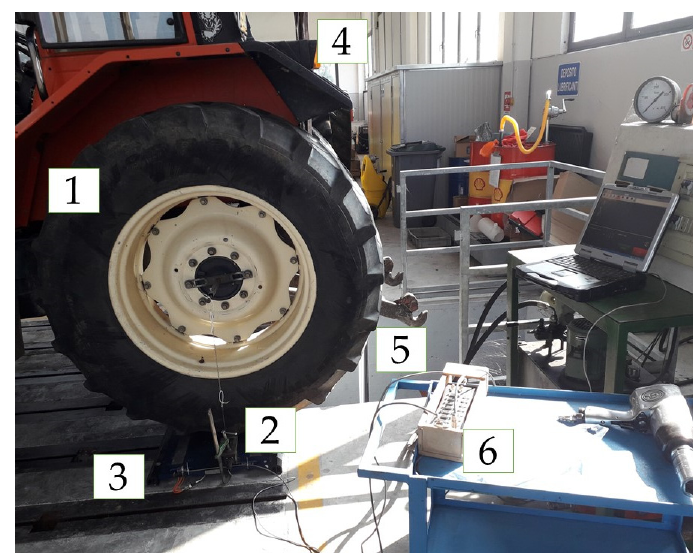
Figure 2. Experimental setup for the measurement of the elastic properties of the tyres: ( 1 ) Tested tyre (in this case: 460/85 R34); ( 2 ) transducer; ( 3 ) weighing platform; ( 4 ) crane rope; ( 5 ) hydraulic cylinder; ( 6 ) acquisition system (connected to the laptop on the right side of the photograph, used to store the data collected).